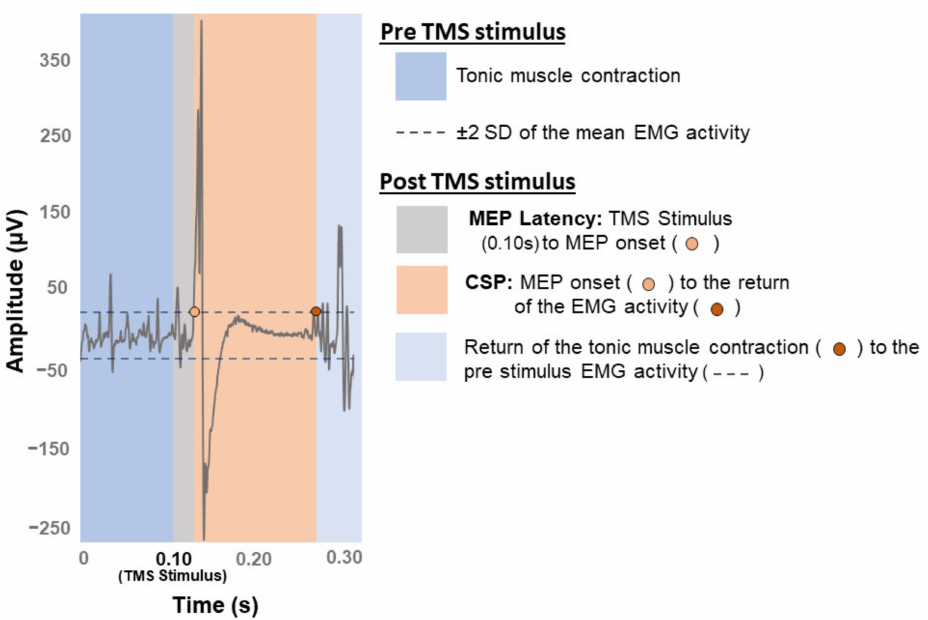
Figure 4. Deriving data from a contralateral Transcranial Magnetic Stimulation (TMS)-induced Motor Evoked Potential (MEP). Representative MEP from contralateral hand muscle showing background electromyography (EMG) activity (tonic contraction) before the TMS stimulus (0.10 s on the timescale). EMG change is evaluated based on ± 2 SD from the mean indicated as dashed lines. MEP latency, peak-to-peak MEP amplitude, and length of the cortical silent period (CSP is derived during offline